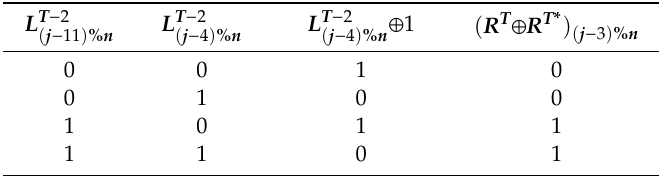
and ( R T ⊕ R T ∗ ) ( j − 3 ) % n ( j − 11 ) % n